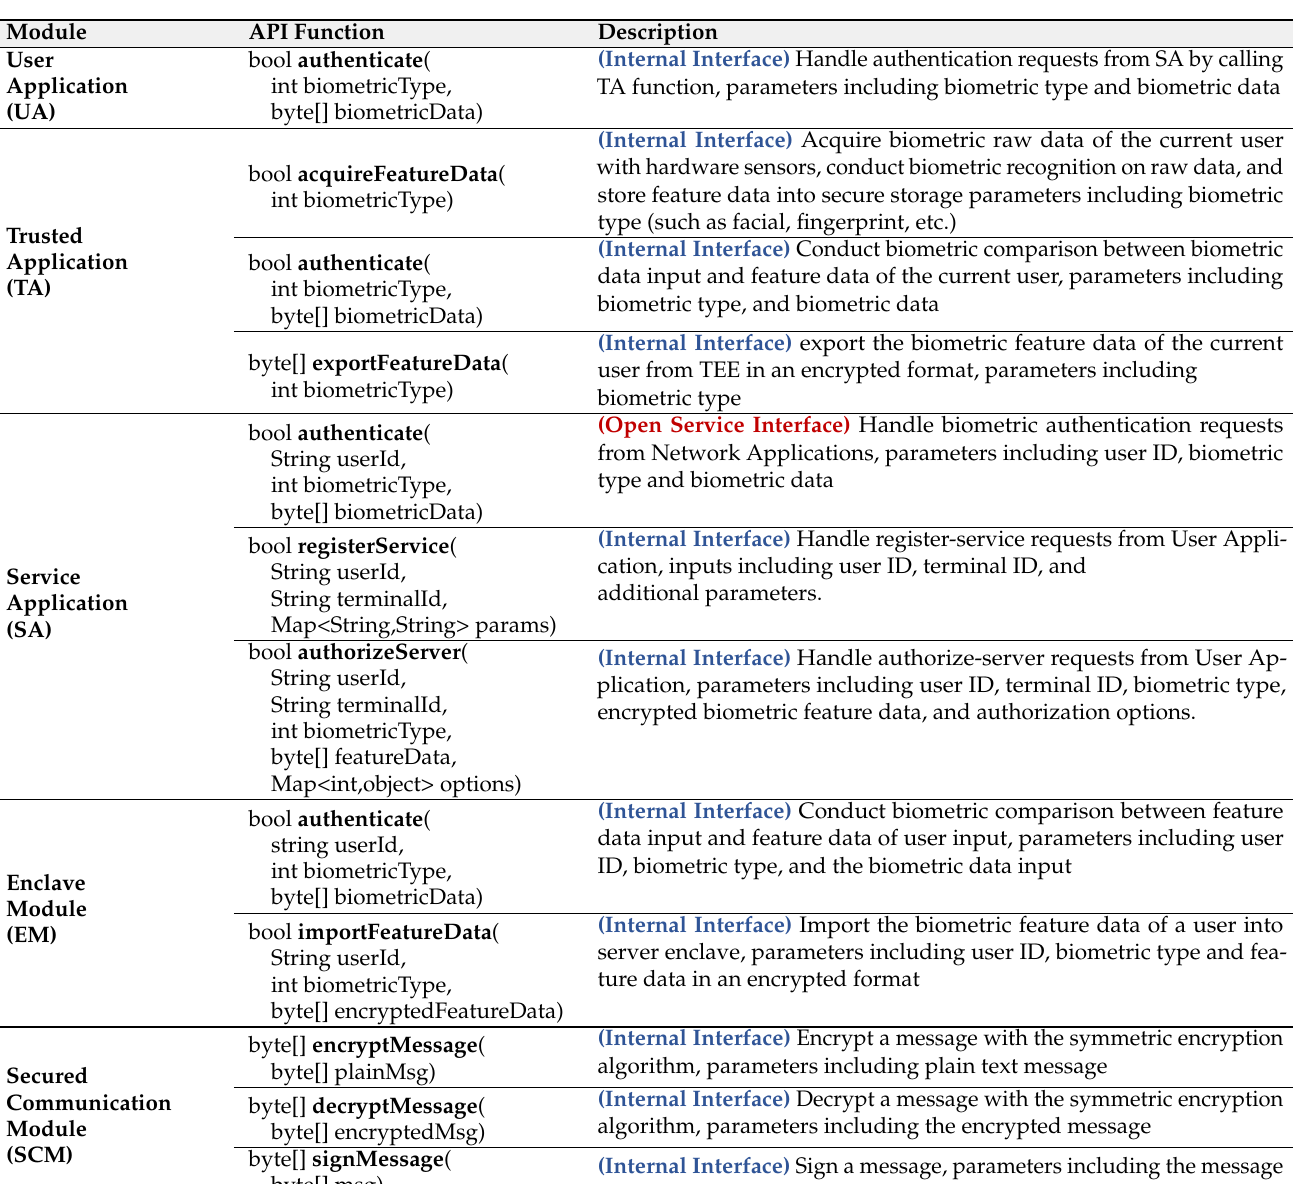
Table 1. Standard Interface for